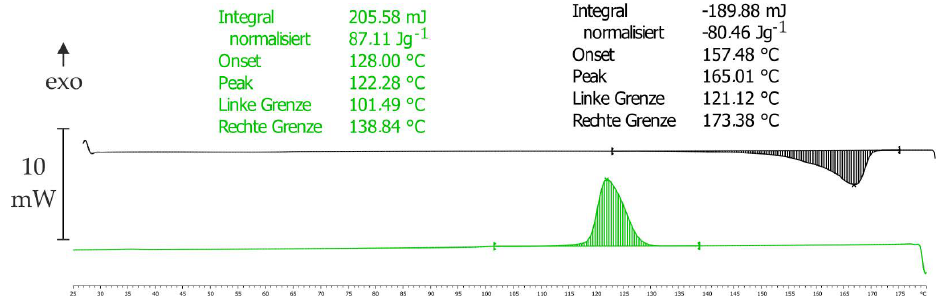
Figure 5. Experimental results of the DSC to identify the process temperature parameters.